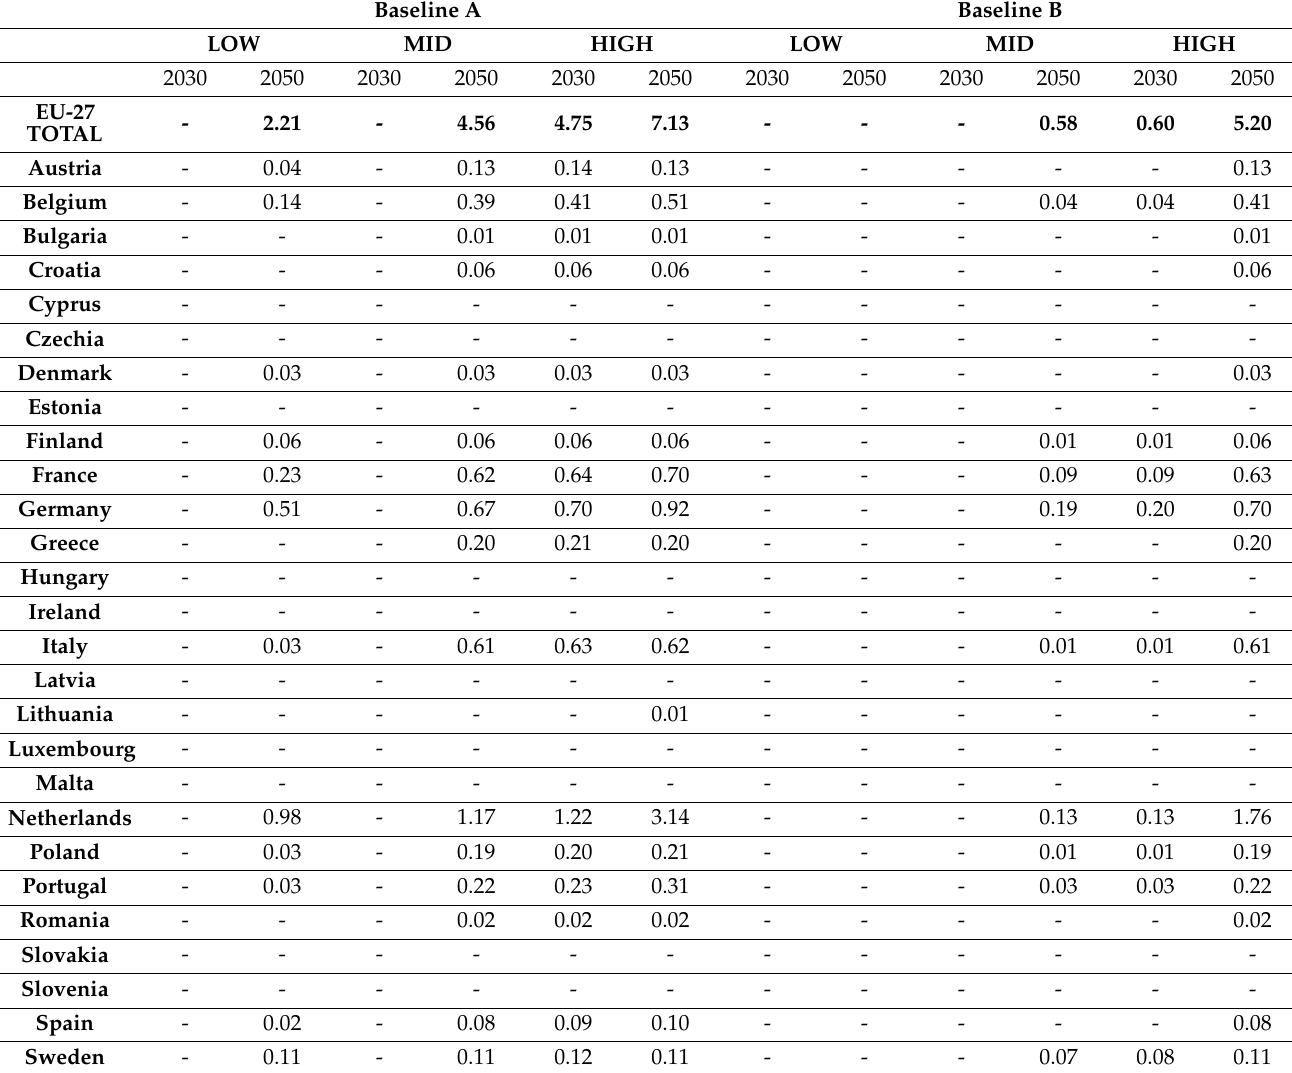
Table A3. LCAF technical potential at Member State level (Mtoe), calculated using free-allocation method. Baseline